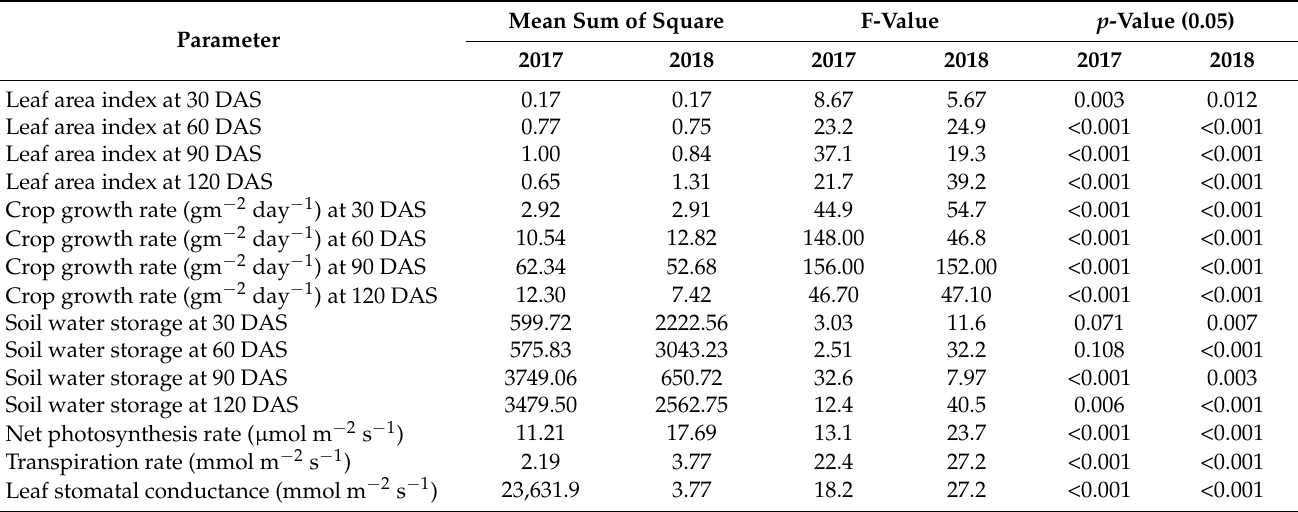
Table 3. Summary of the analysis variance for leaf area index, crop growth rate, soil water stor- age, net photosynthesis rate, transpiration rate and stomatal conductance of maize under different mulching materials.